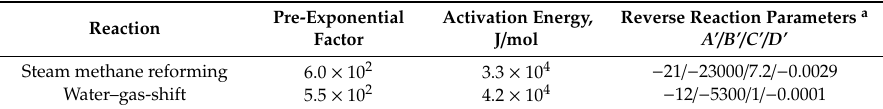
Table 3. Parameters for reaction